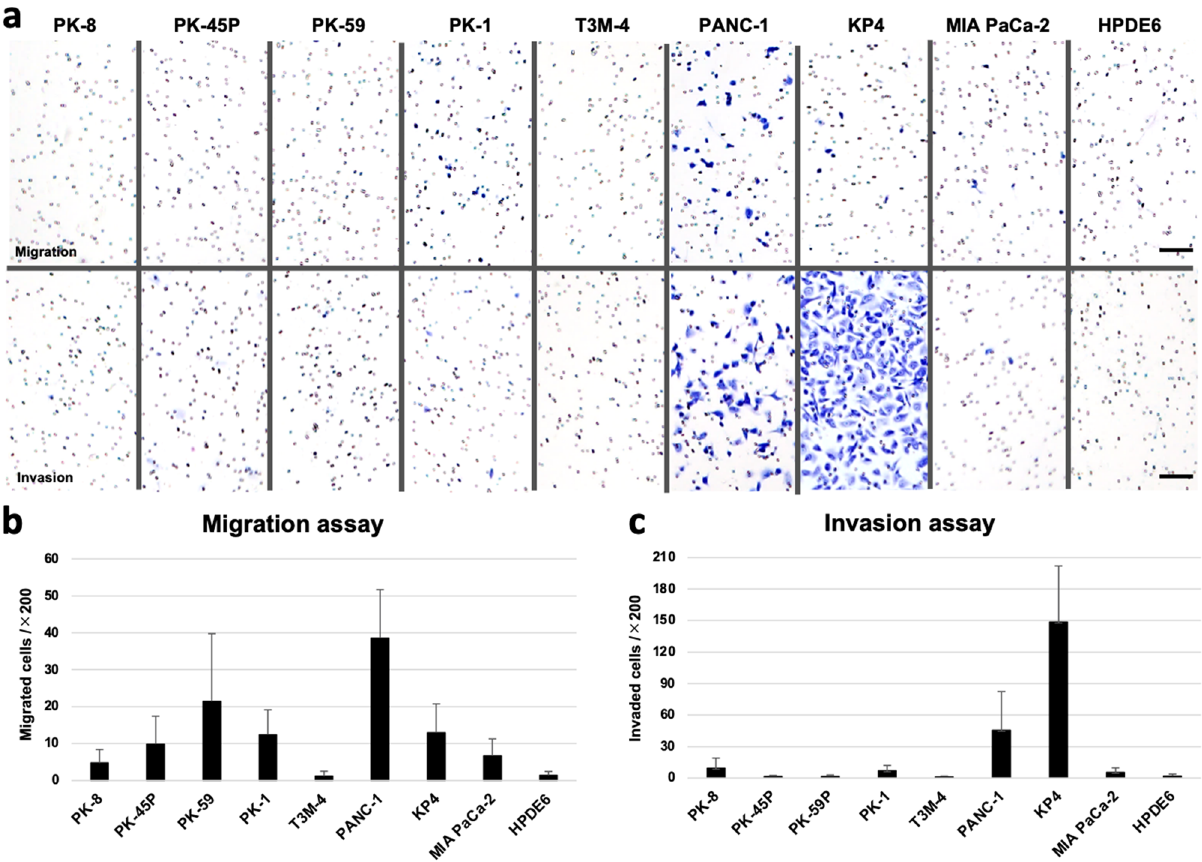
Figure 4. Transwell migration and invasion assays. PANC-1 cells showed the highest migratory ability ( a , upper row; b ), and PK4 showed the highest and PANC-1 cells showed the second highest invasion ability ( a , lower row; c ). Scale bar = 100 μm. Data are shown as the mean ±